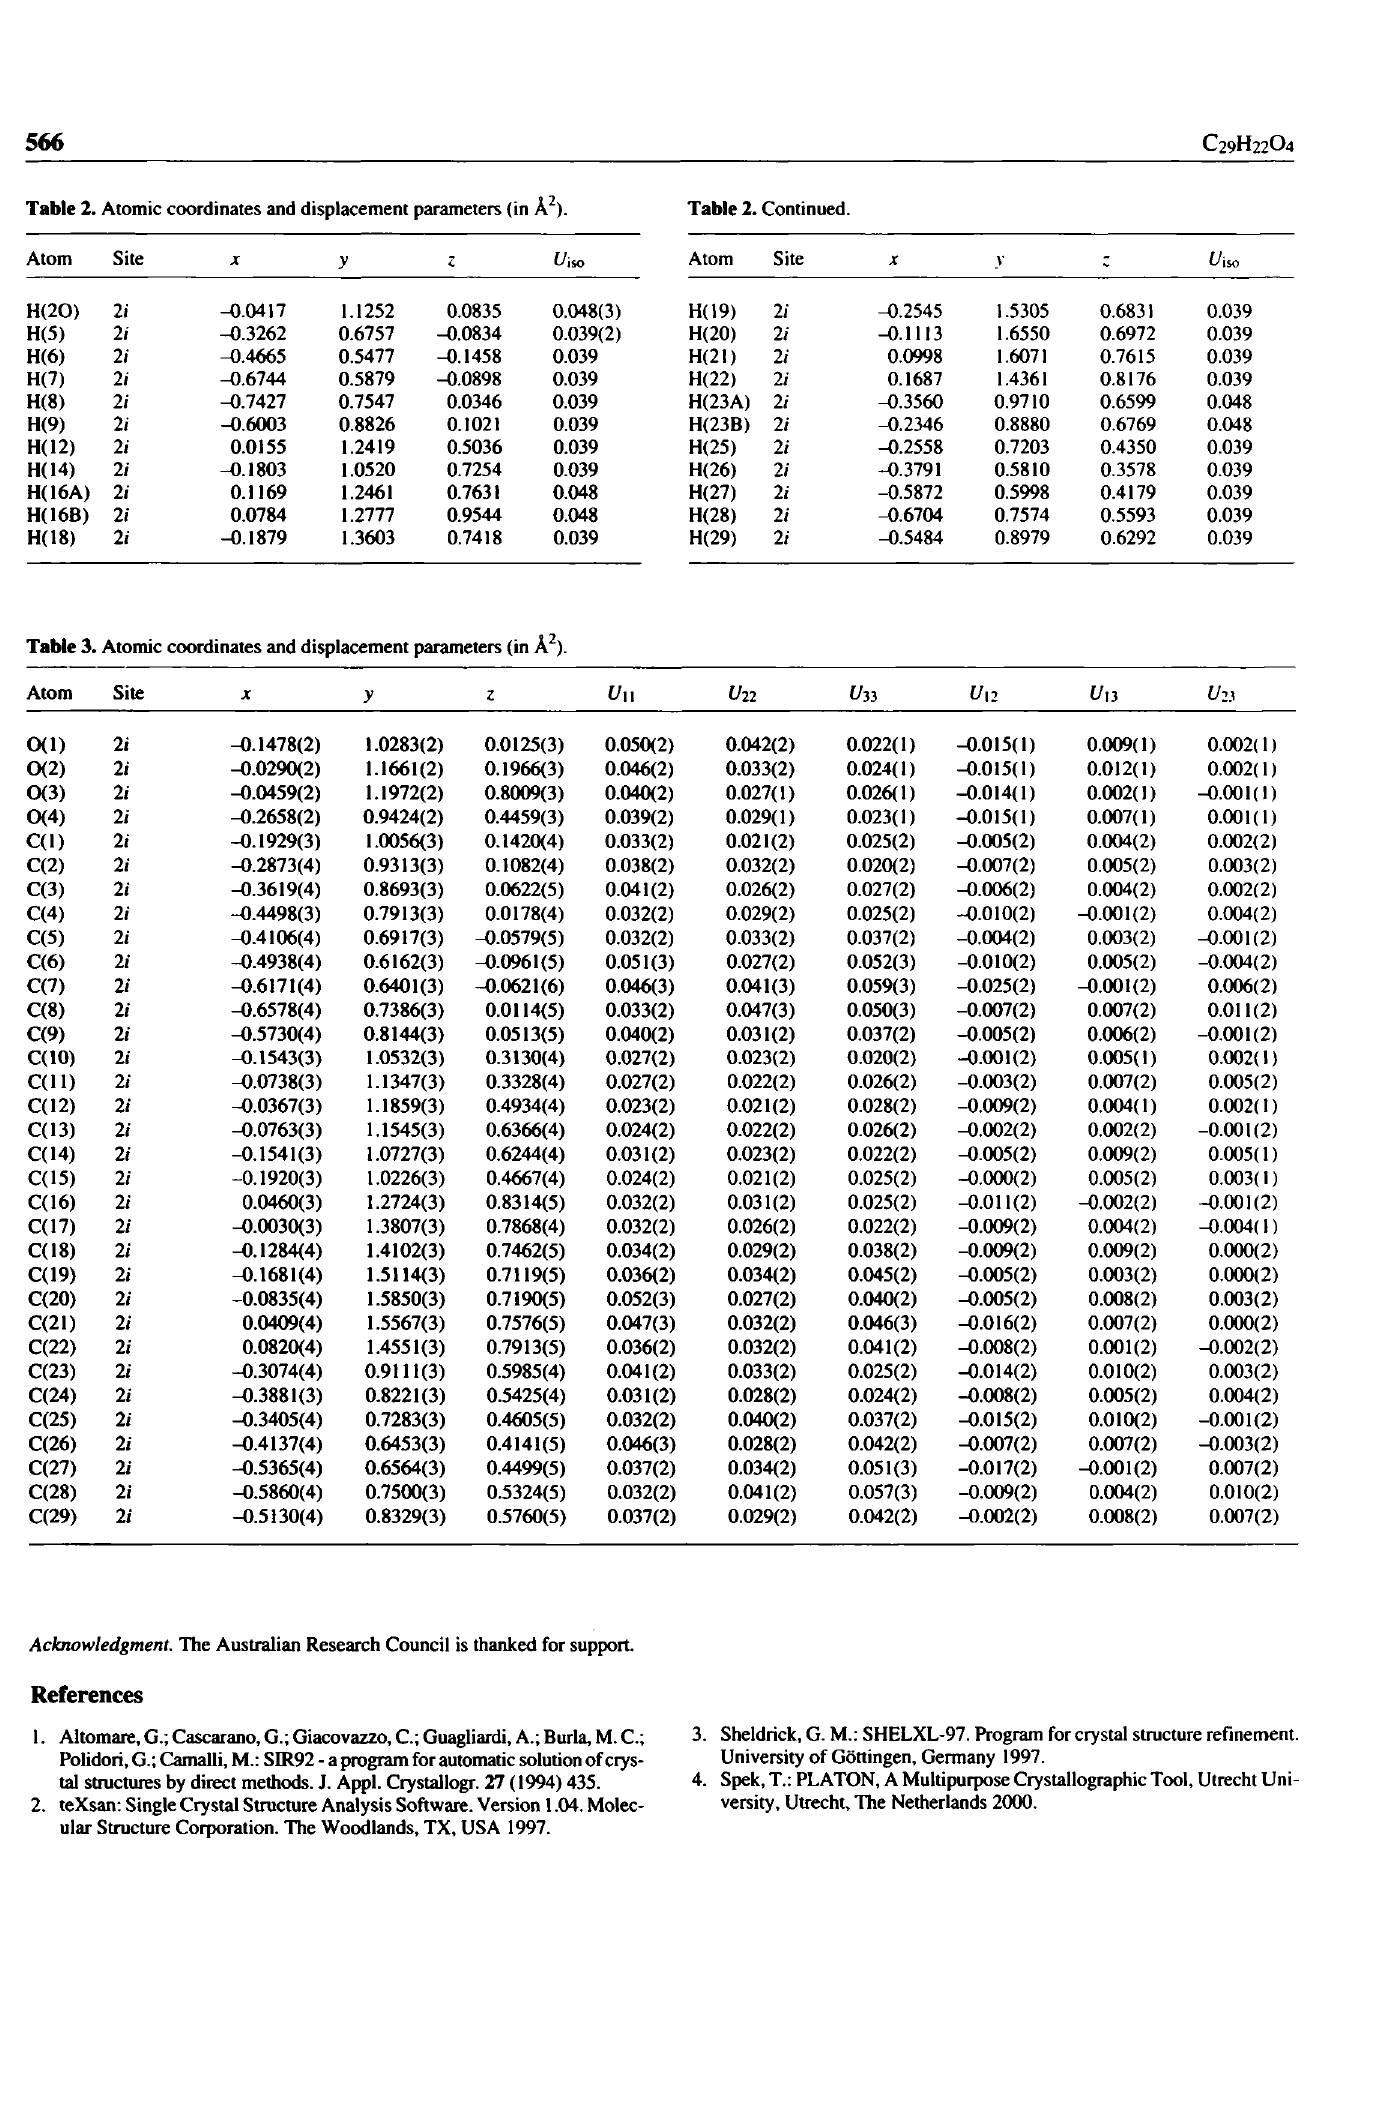
Table 3. Atomic coordinates and displacement parameters (in A 2